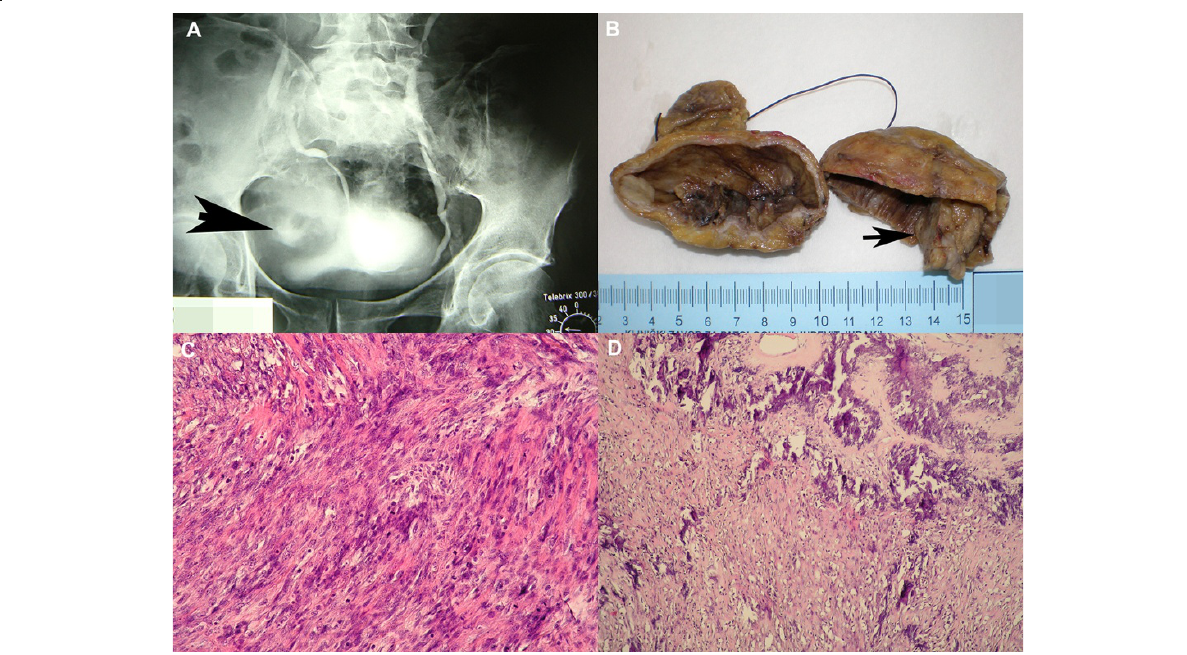
Figure 1 Radiographic, macroscopic and histological findings . A) Intravenous urography showing large bladder diverticulum, measuring 7 × 7 cm, with 3 cm stone-like component within (arrow). Diverticulum was compressing the bladder and dislocating right ureter towards the central line. B) Macroscopically, the bladder diverticulum contained grayish, solid tumor with gritty, firm centre that measured 3.5 cm in the largest diameter (arrow). C) The tumor was composed of anaplastic, oval to spindle cells, with prominent mitotic activity, partly rimmed with osteoid (HE, × 200). D ) The central part of the tumor was composed of mineralized osteoid, deposited as irregular trabeculae with malignant osteocytes (HE, ×